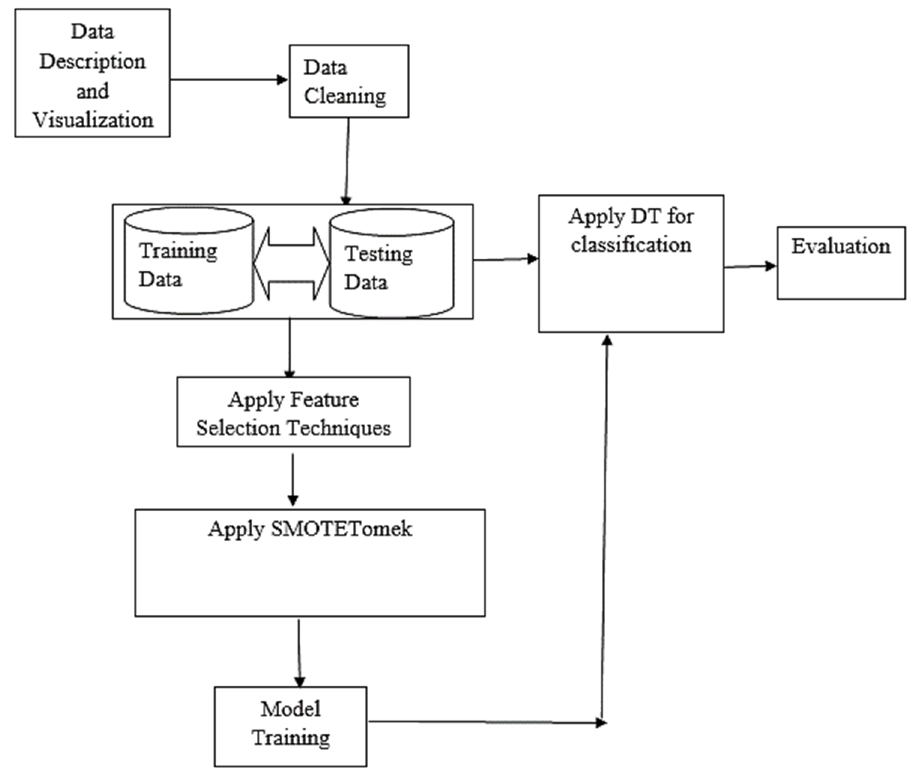
Figure 3. Architecture of the